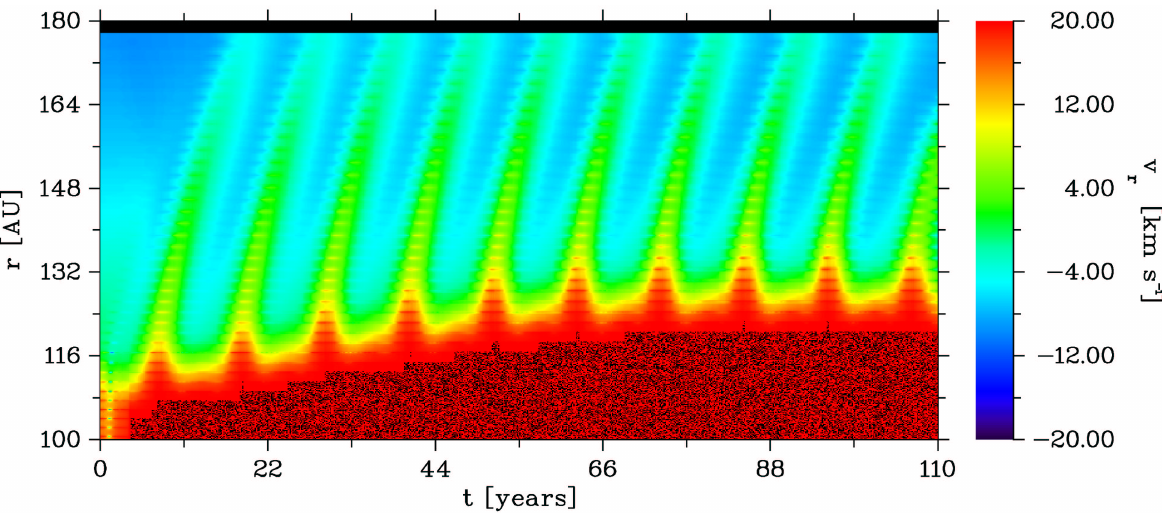
Fig. 6. The Mach-number of the protons along the stagnation axis for almost 11 solar cycles.